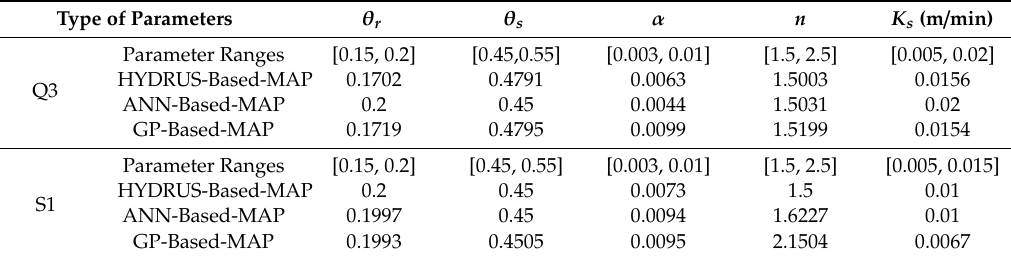
Table 1. Parameter ranges and MAP inversed by three di ff erent methods.